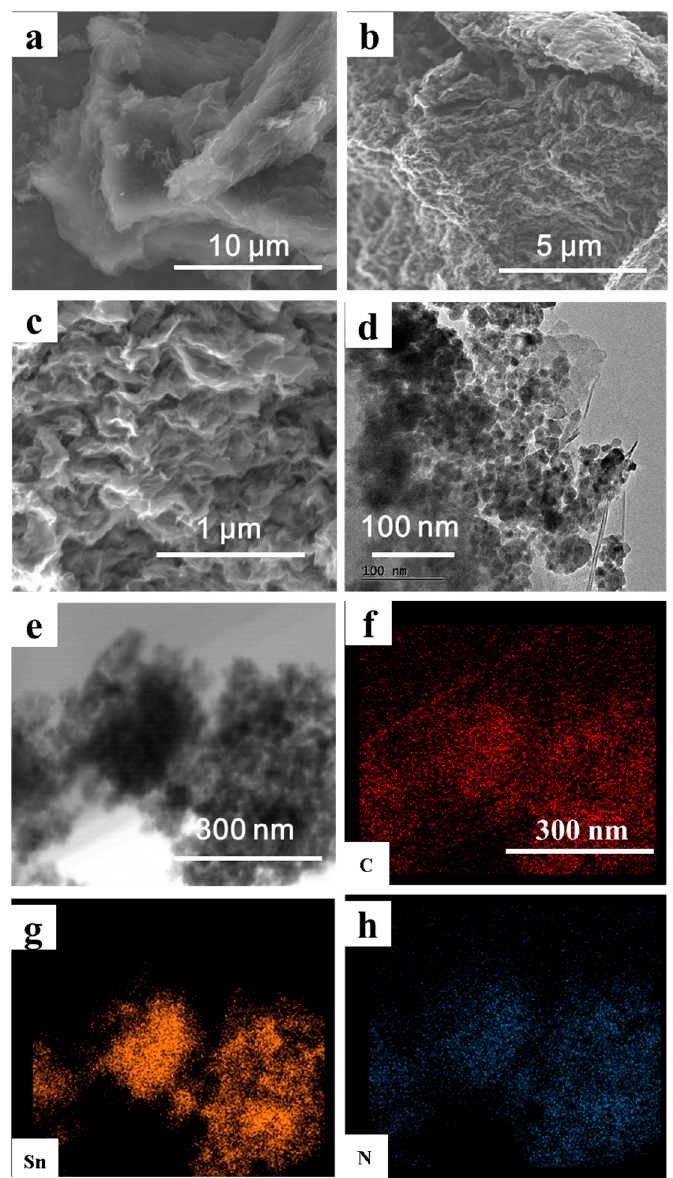
Figure 2. Characteristics of the Sn@N-G composite. ( a – c ) Scanning electron microscopy (SEM) images of the Sn@N-G composite; ( d ) Transmission electron microscopy (TEM) images of the Sn@N-G composite; ( e – h ) the mapping of Sn, N, and C elements.